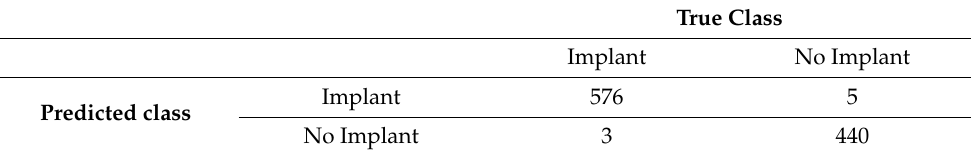
Table 5. Confusion table of the support vector machine classification using a quadratic